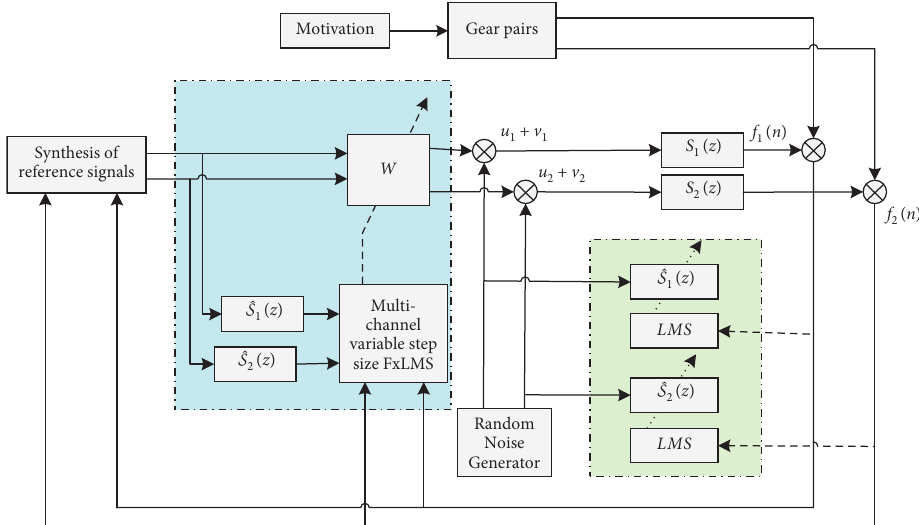
Figure 10: Multiharmonic vibration active control of the two-stage gear transmission system.